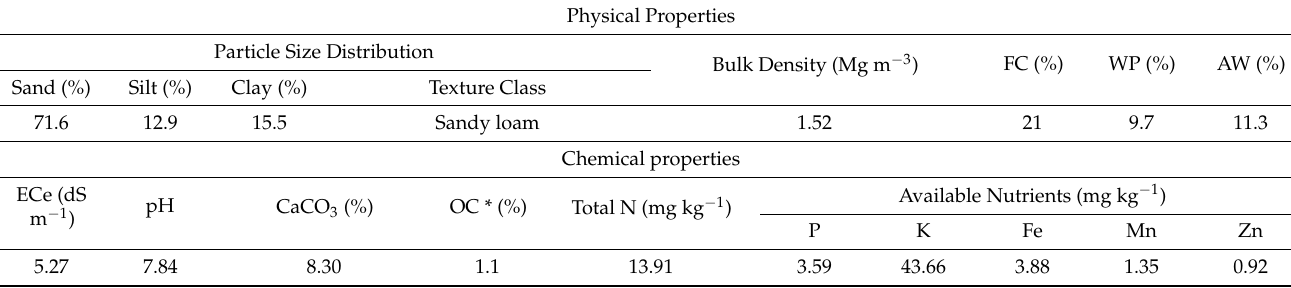
Table 1. Some initial physical and chemical properties of the experimental